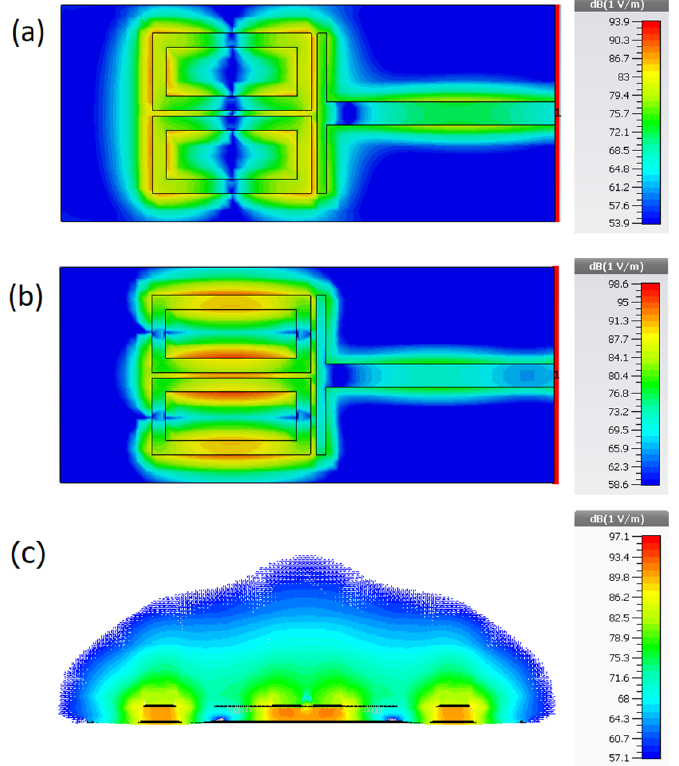
Figure 2. Total electric field distribution for ( a ) the first resonance at 4.958 GHz, ( b ) second resonance at 5.652 GHz, ( c ) transverse cross-section in the middle of ring resonators at 5.652 GHz.